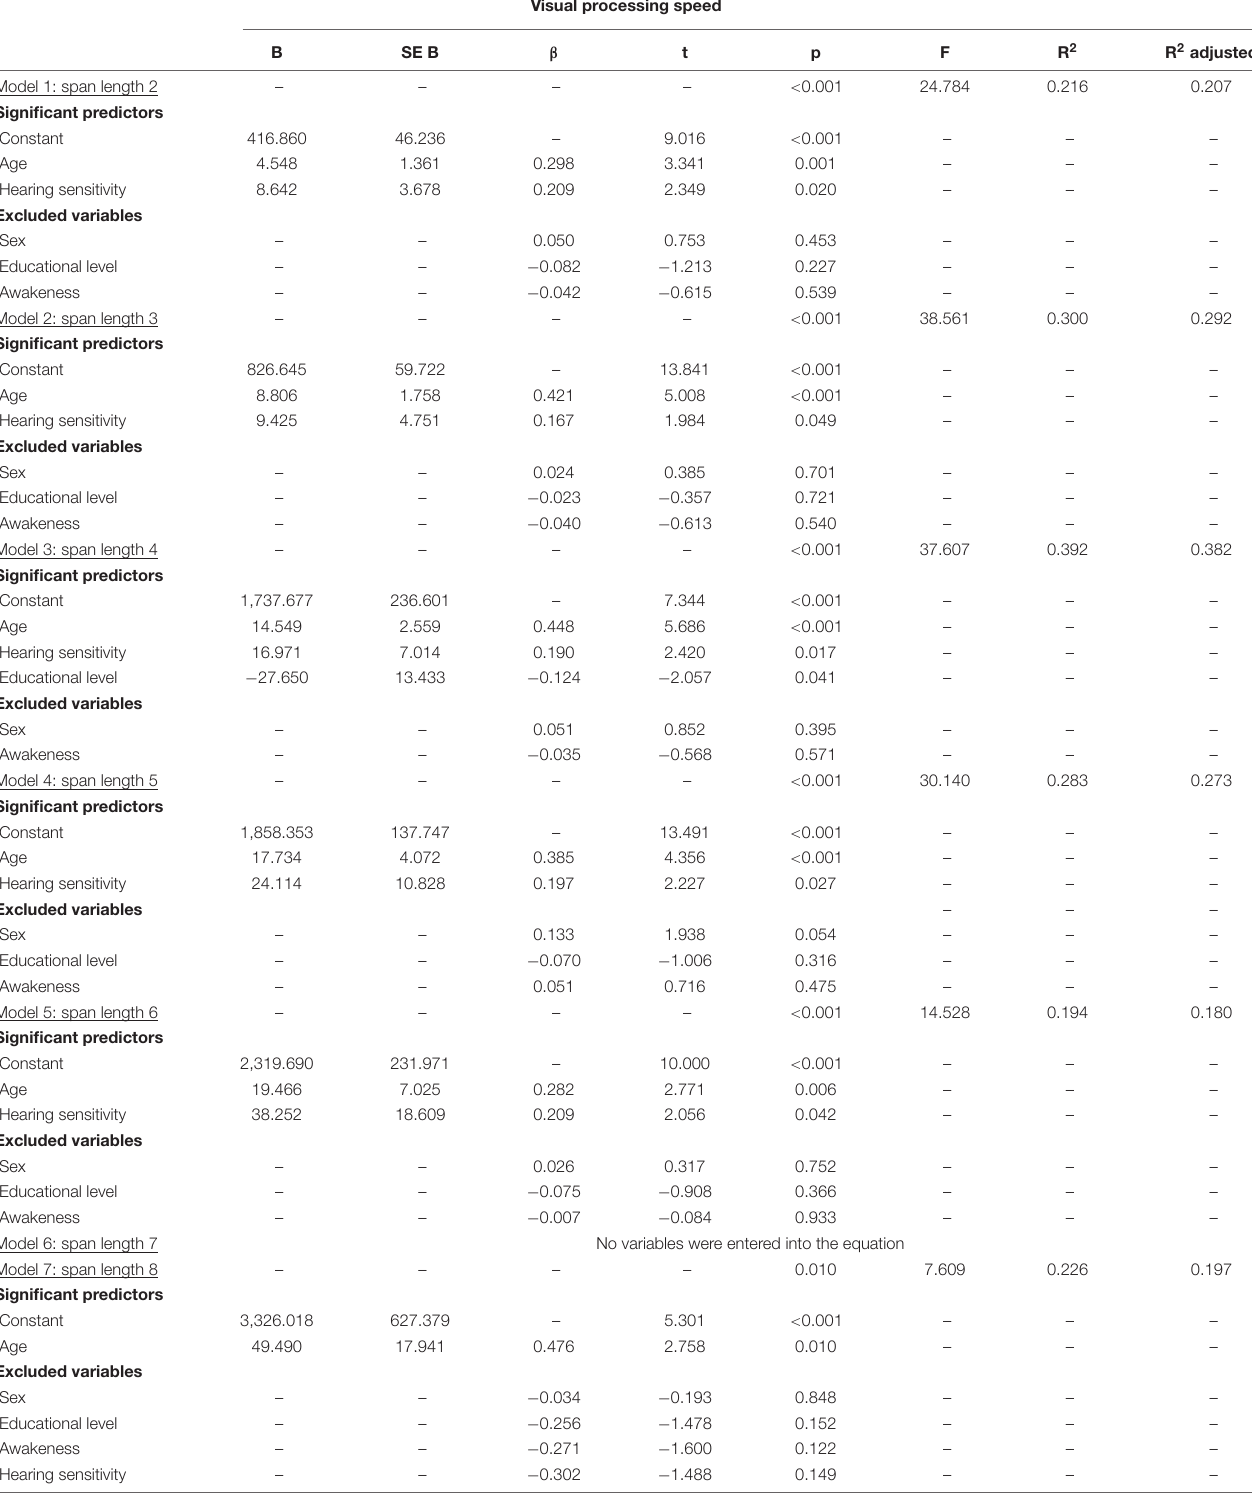
TABLE 8 | Stepwise multiple regression with age, sex, educational level, awakeness, and hearing sensitivity as independent variables and visual processing speed at each span length as dependent